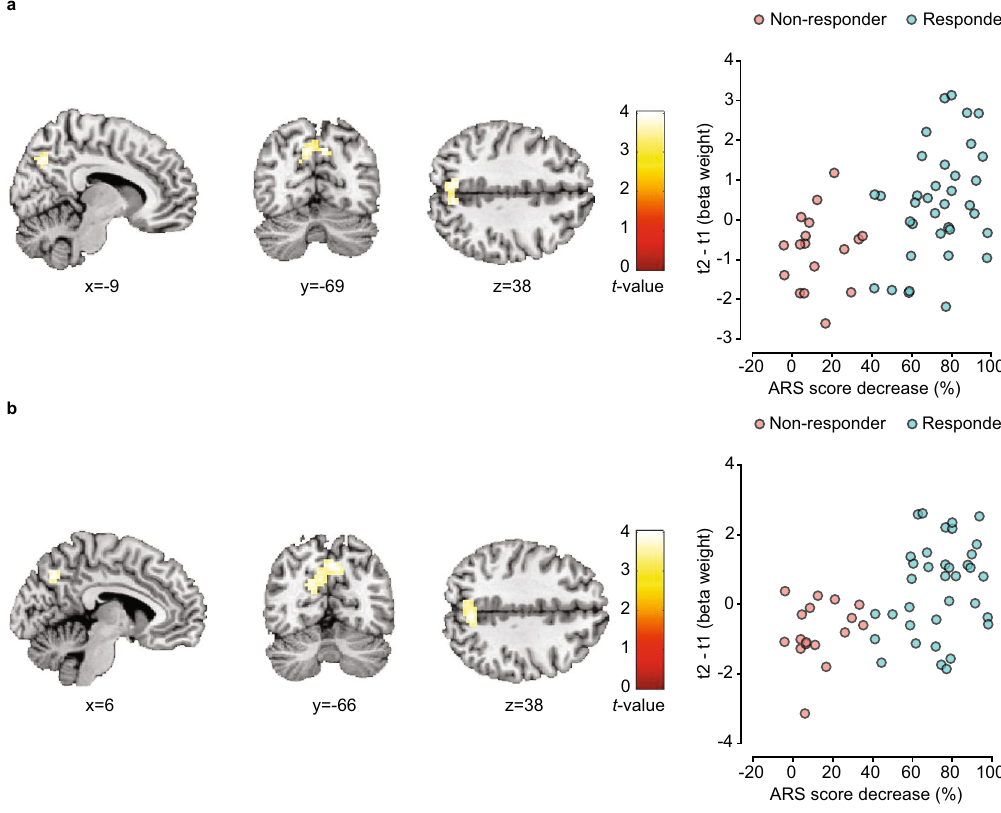
Figure 4. Correlation between BOLD response and the relative ARS score decrease after following an FFD (n = 53). ( a ) Significant precuneus cluster ([whole-brain] p FWE = 0.015) showing a positive correlation between the absolute change (t2 − t1) in the StopSuccess > Go contrast and the ARS score decrease (100 × [t1 − t2]/t1). ( b ) Significant precuneus cluster ([whole-brain] p FWE < 0.001) showing a positive correlation between the absolute change (t2 − t1) in the StopSuccess > StopFail contrast and the ARS score decrease (100 × [t1 − t2]/t1). The cluster extent was set at k > 50 to only show significant clusters (p FWE < 0.05, whole-brain). All mentioned coordinates are Montreal Neurological Institute (MNI) stereotaxic coordinates. The colour bars reflect peak t values. See Table 3 for details per cluster. For illustration purposes, scatter plots, showing the correlation between the ARS score decrease (100 * [t1 − t2]/t1) and cluster-averaged beta weights for the StopSuccess > Go (t2 − t1) and StopSuccess > StopFail (t2 − t1) contrasts in the precuneus, were added on the right side of the corresponding brain images. Higher beta-weights correspond with a higher activation. Blue dots represent responders (≥ 40% ARS score decrease at t2 versus t1), red dots represent non-responders (< 40% ARS score decrease at t2 versus t1). ARS attention-deficit hyperactivity disorder (ADHD) rating scale, FFD few foods diet, p FWE -value family- wise-error-corrected p value, t1 before start FFD, t2 at the end of the FFD.